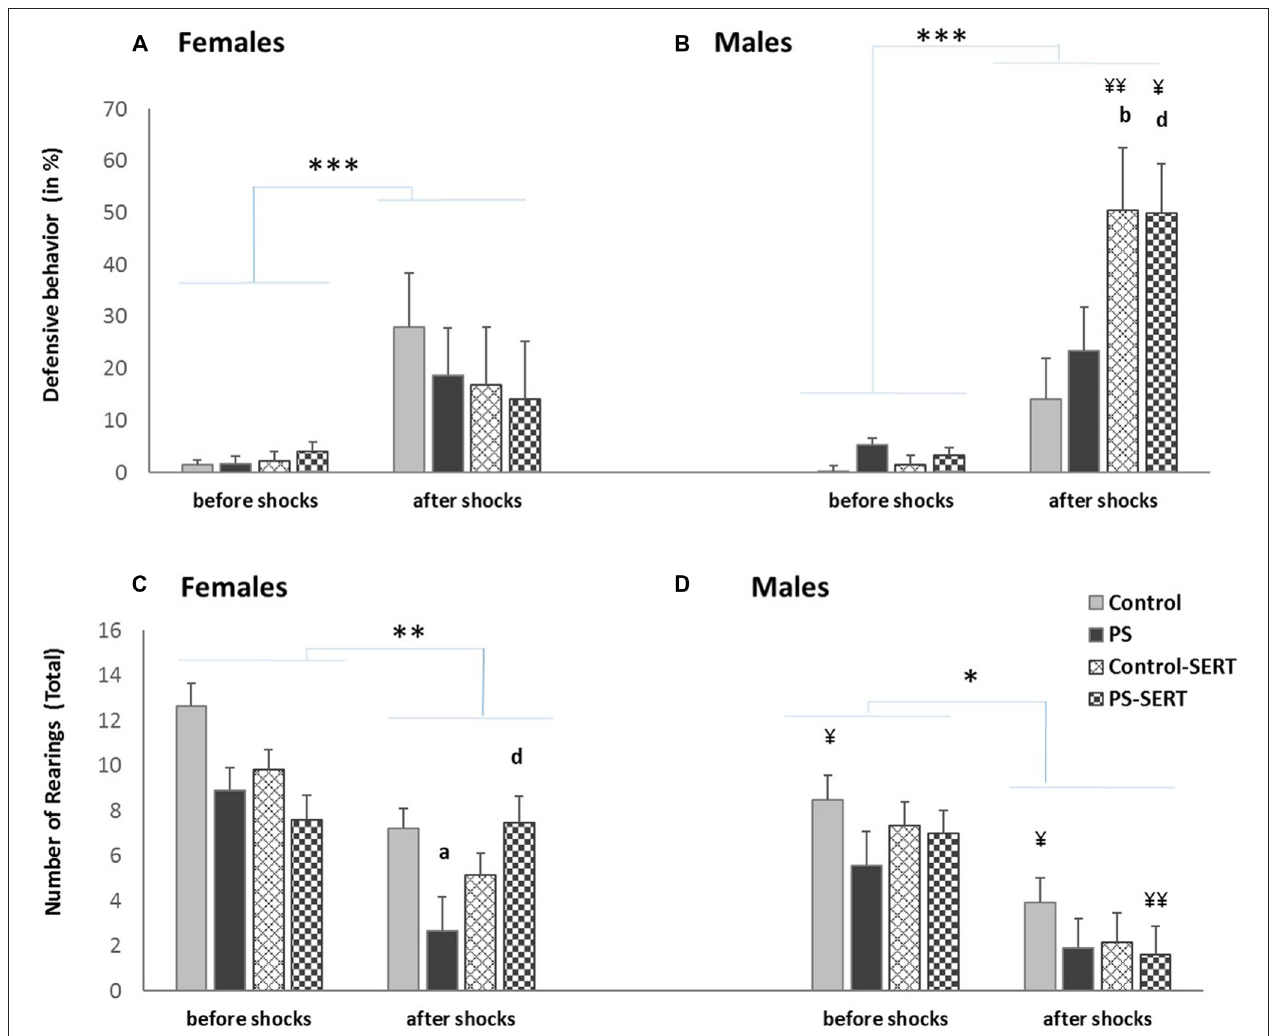
FIGURE 4 | Effects of a session of inescapable shocks (IS) in the time the animals of both sexes spent displaying defensive behavior (in%) (A,B) ; and in the number of rearings (C,D) during the CFC paradigm test. Before shocks: each bar represents the mean values + SE in the two sessions before the IS; after shocks: each bar represents the mean values + SE in the three sessions after the IS. a p < 0.05, indicates the differences as effect of prenatal stress; b p < 0.05, indicates the differences as effect of SERT in control animals; d p < 0.05 indicates the significant effects of SERT in prenatally stressed females; (cid:85)(cid:85) p < 0.01 and (cid:85) p < 0.05, indicate the differences between sexes; ∗∗∗ p < 0.001, ∗∗ p < 0.01 and ∗ p < 0.05 indicate the significant change between the sessions before vs. after